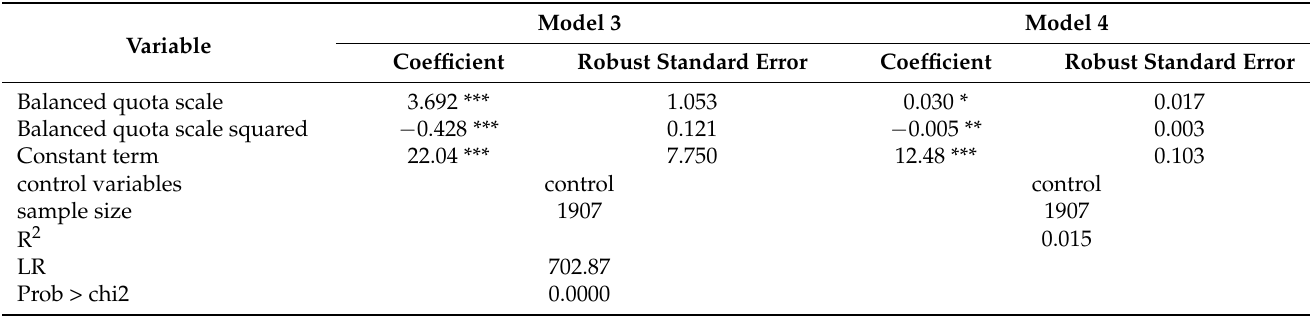
Table 5. Robustness test of model estimation